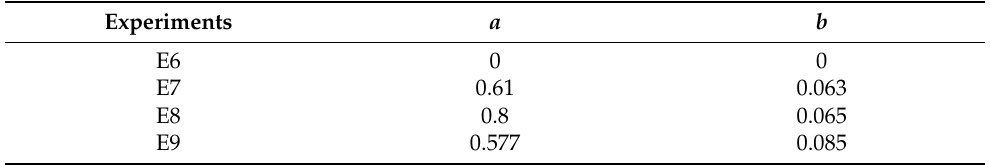
Table 3. Experimental results of the estimation of the influence of the initial values of a and b in the C d expression on the storm surge